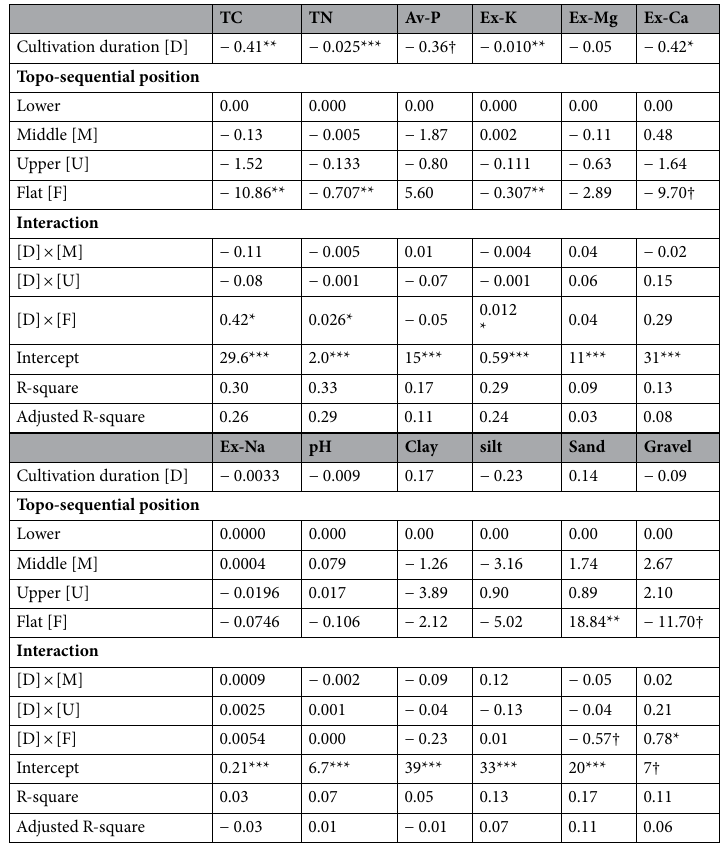
Table 2. ANCOVA results to estimate the effects of maize cultivation duration and topo-sequential position on soil properties. † , *, **, and ***Represent statistical significance at p < 0.1, 0.05, 0.01, and 0.001, respectively.